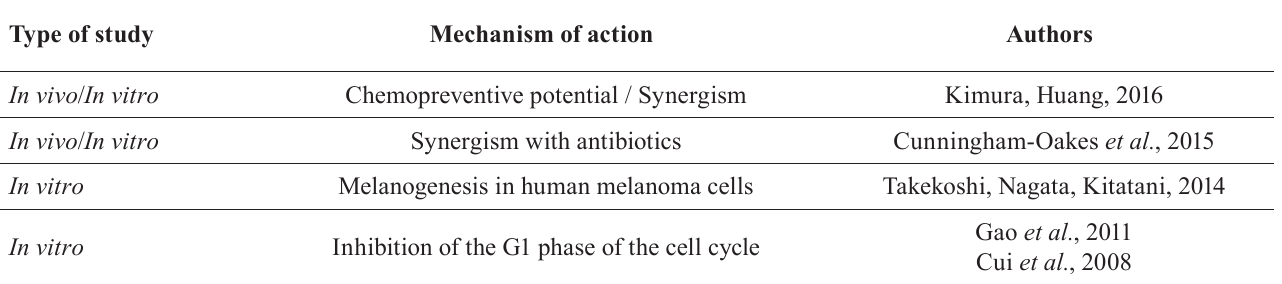
TABLE I - M echanism used by NDGA in different studies